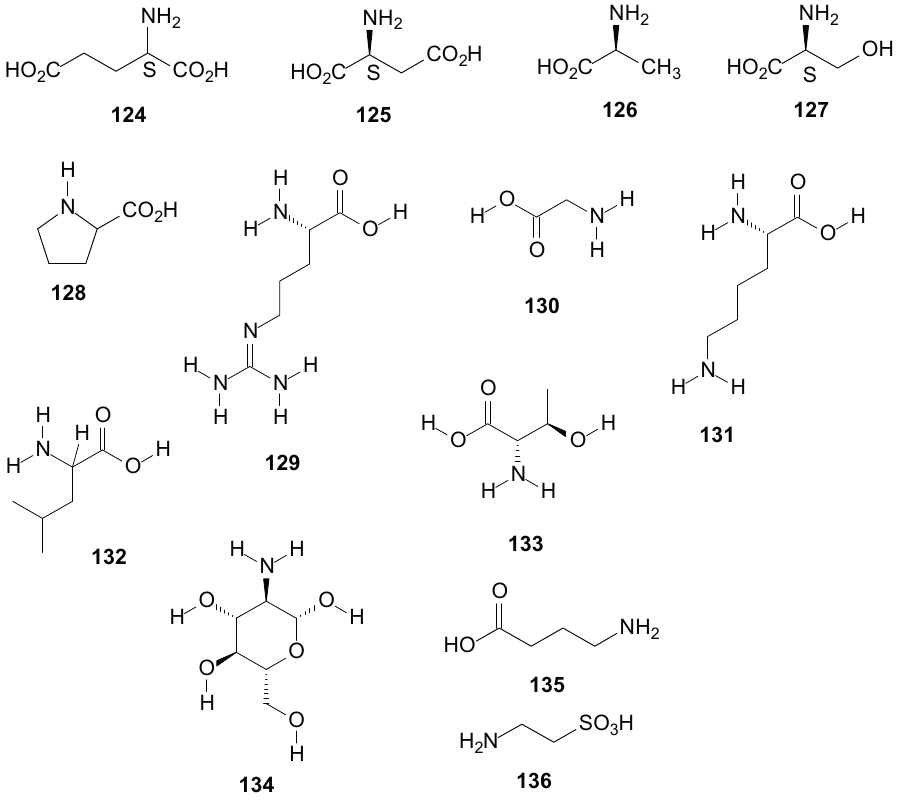
Figure 9. Chemical structures of other compounds: amino acids from Ramalina species of the fungi. Organic acids and derivatives as well as fatty acids esters were found in Ramalina species . α -Crotonic acid ( 145 ) was isolated from R. reticulata [26] and abscisic acid ( 146 ) from R. farinacea [129], while from R. fastigiata [141] were isolated the esters ethyl caprilate ( 147 ), ethyl palmitate ( 148 ) and ethyl stearate ( 149 ). The compounds benzopyran divaricat acid ( 150 ) and anthraquinone ( 151 ) were found in R. hierrensis